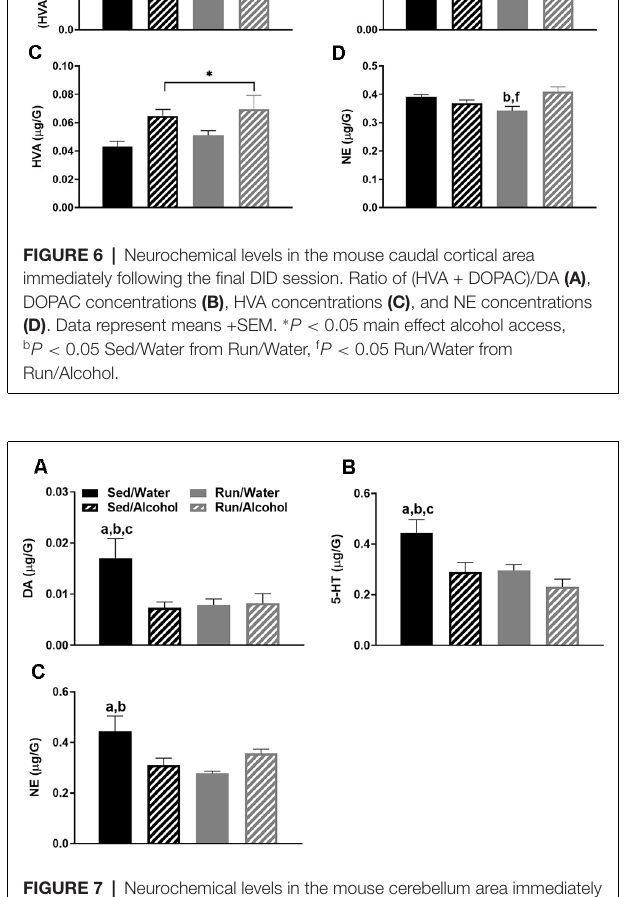
FIGURE 7 | Neurochemical levels in the mouse cerebellum area immediately following the final DID session. DA concentrations (A) , 5-HT concentrations (B) , and NE concentrations (C) . Data represent means +SEM. a P < 0.05 Sed/Water from Sed/Alcohol, b P < 0.05 Sed/Water from Run/Water, c P < 0.05 Sed/Water from Run/Alcohol.